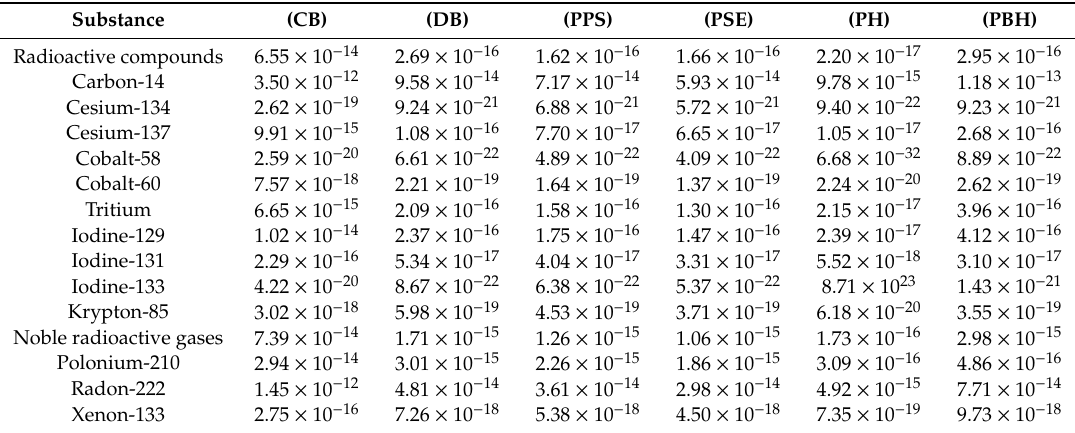
Table 3. Emission of ionizing radiation compounds into the air throughout the shaping cycle of PLA beverage bottles which is biodegradable in an industrial composting facility.